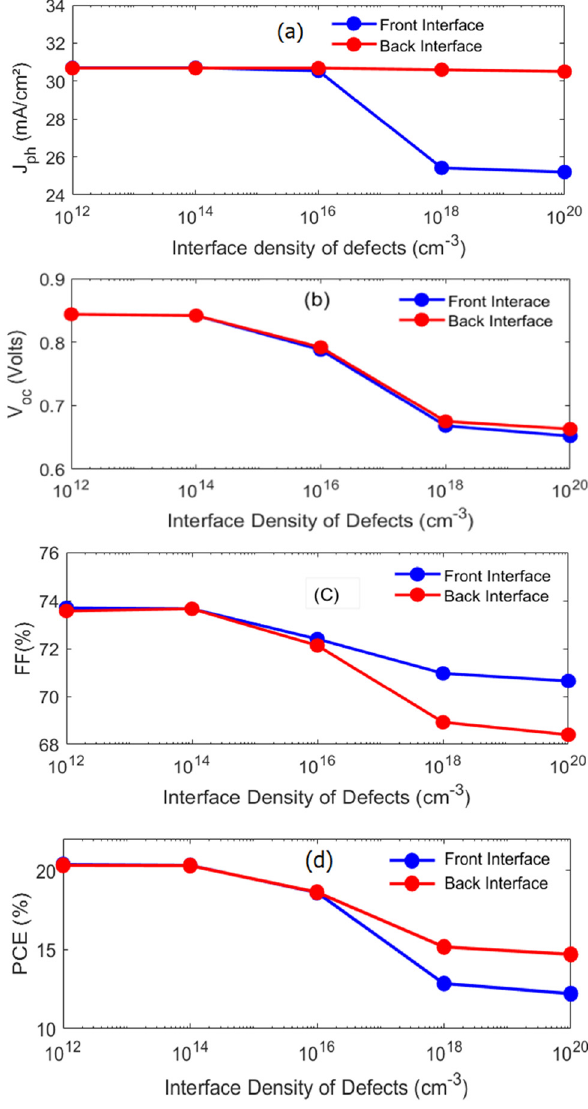
Figure 2: E ff ect of interface density of defects on the photovoltaic parameters of the basic cell structure. ( a ) Short current density, ( b ) open circuit voltage, ( c ) fi ll Factor and ( d ) power conversion e ffi